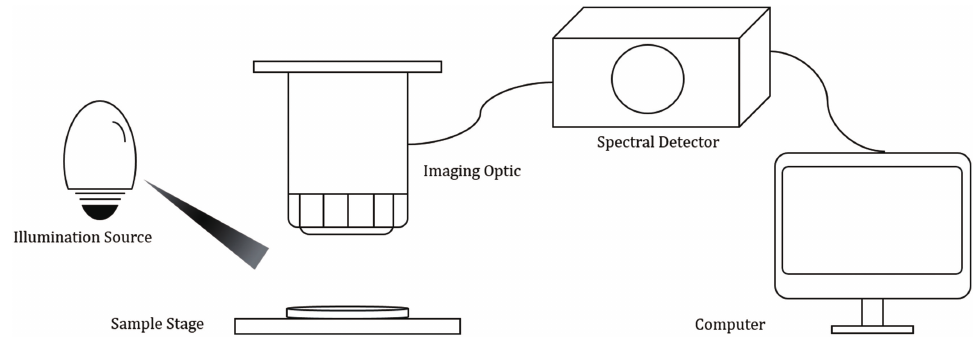
Fig. 1. The composition of a typical CI